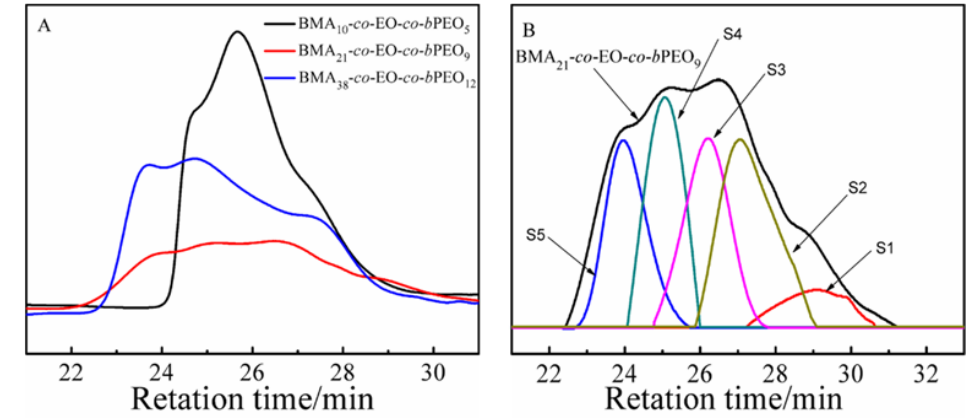
Figure 2. ( A ) SEC curves of copolymers, ( B ) SEC curves of BMA 21 - co -EO- co - b PEO 9 fractionations.